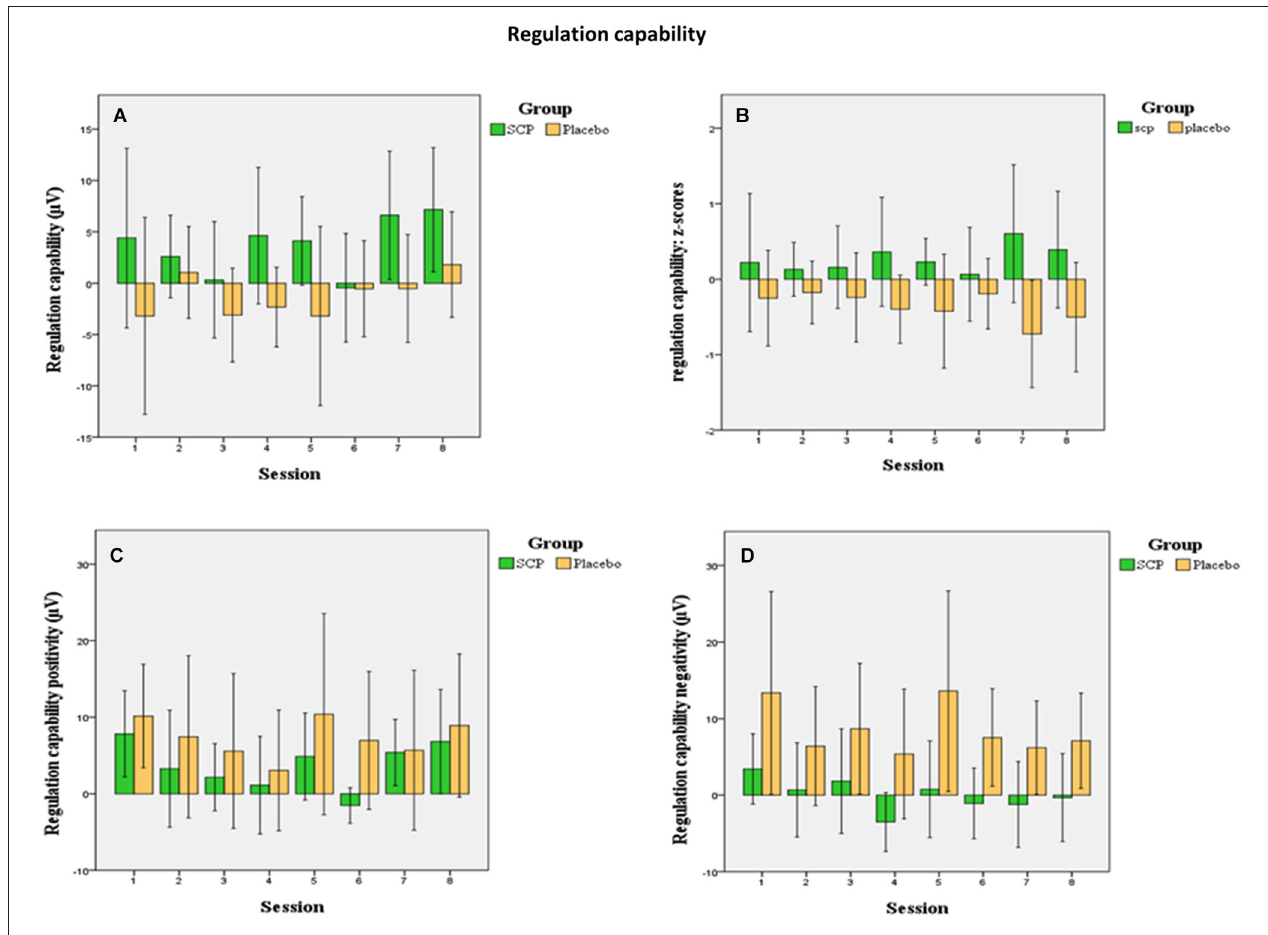
from the mean) session regulation indices . (B) Changes in regulation capability across all sessions for positivity trials (C) indicate no differences between the groups during positivity trials while only the SCP group develops the capability to generate negativity during negativity trials (D)